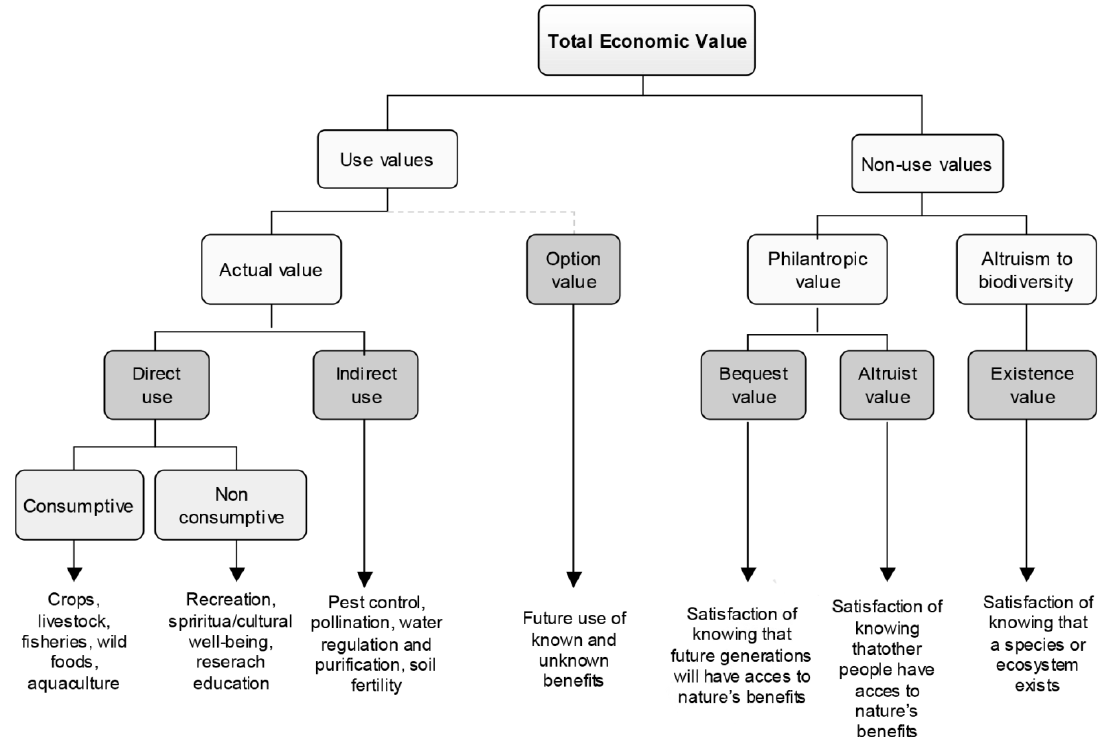
Figure 1. Composition of the Total Economic Value (TEV) of natural resources. Source: TEEB [7], Chapter